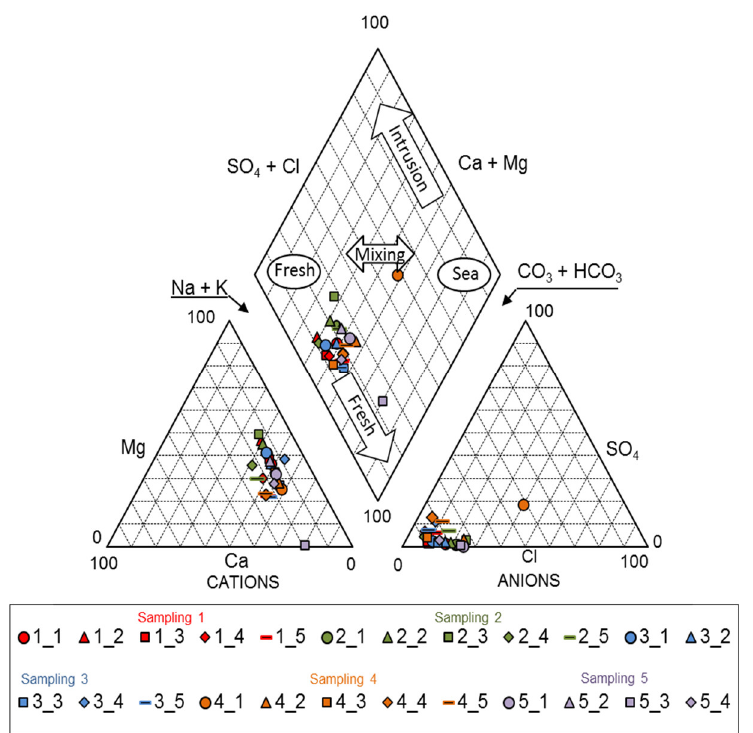
Figure 3. Hydrogeochemistry facies of the groundwater using a Piper